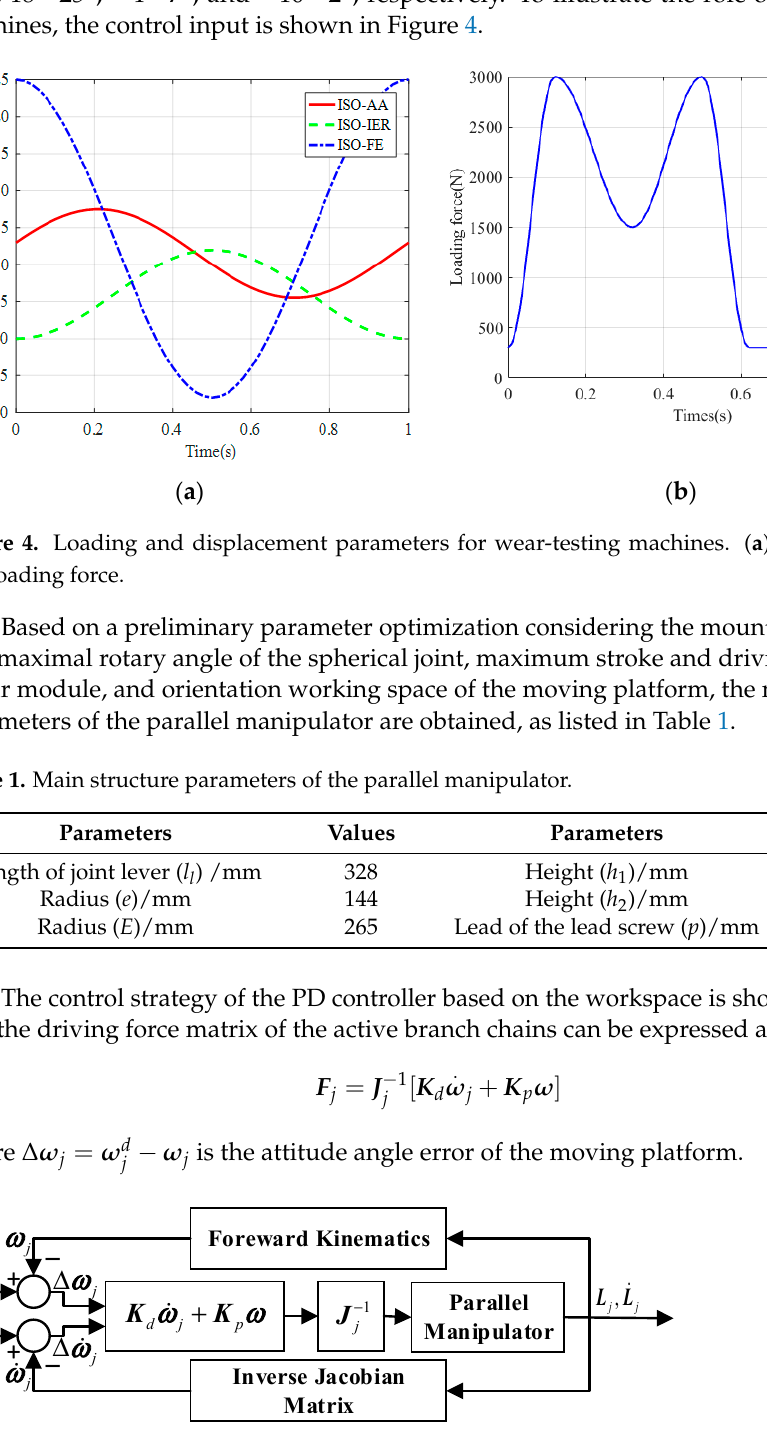
Figure 5. Block diagram of the PD controller.